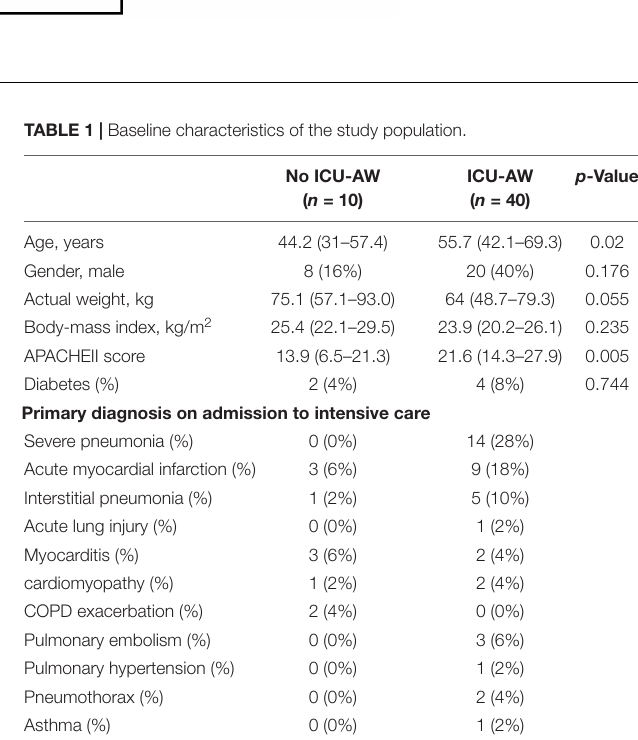
Table 2 demonstrated the therapy details of the study